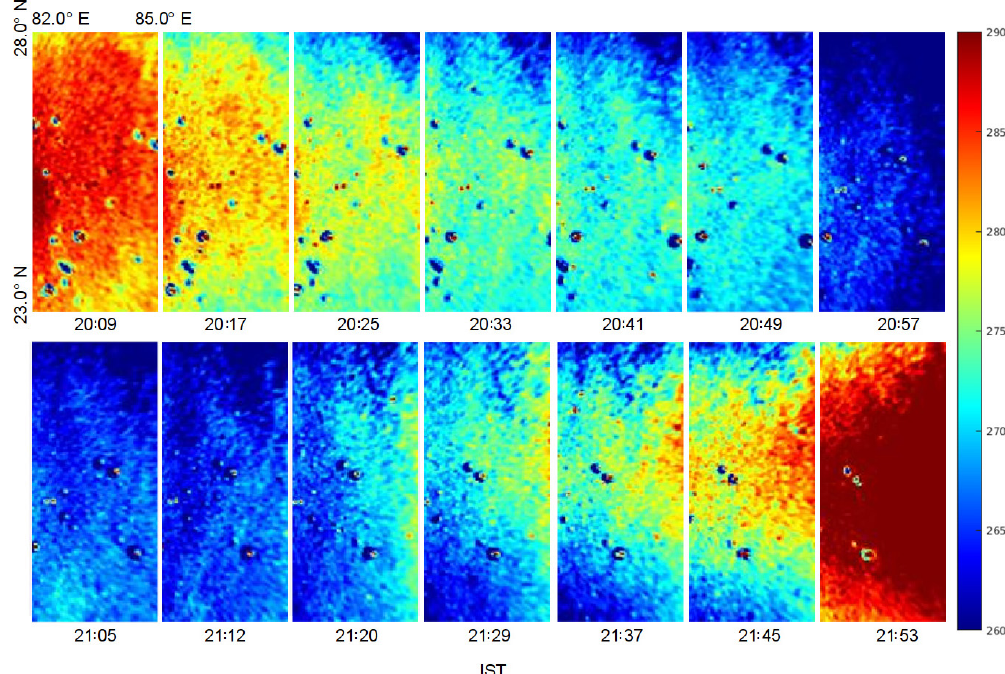
Figure 9. Sequence of airglow-derived hmF2 maps during 20:00–22:00IST on 9 January 2016 (hmF2 is expressed in